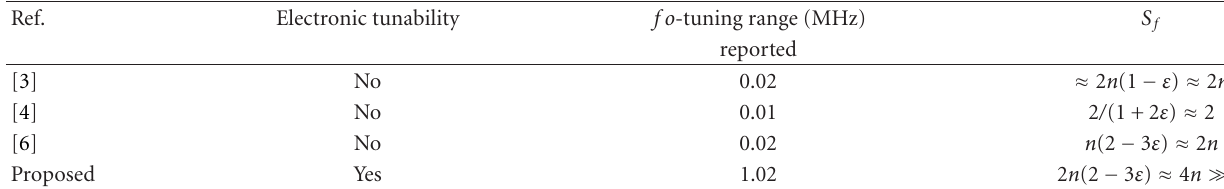
Table 1: S f values for some recent CDBA-based